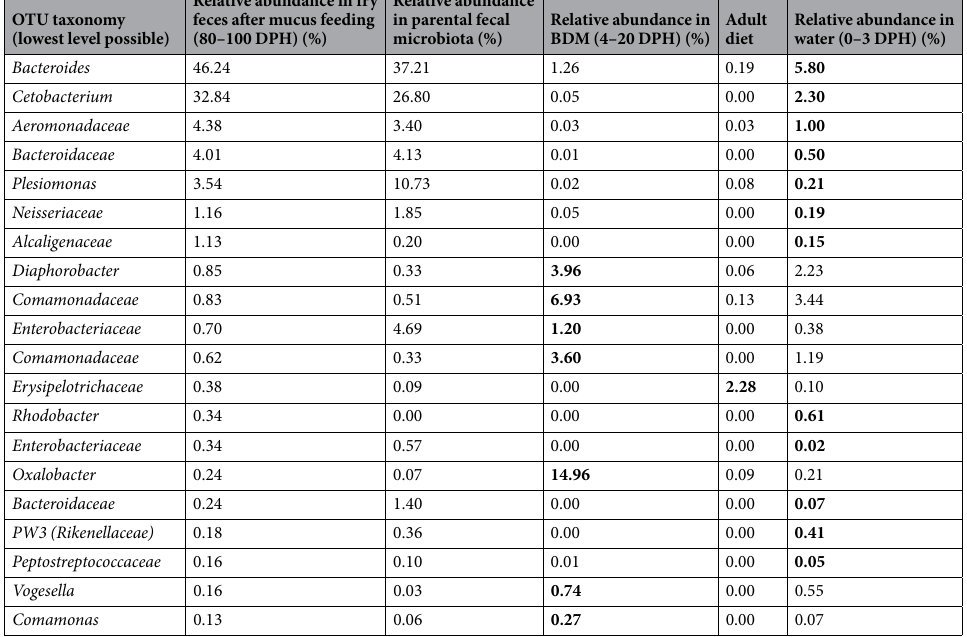
Table 4. The most abundant fecal microbial symbionts of the fry after mucus feeding (80–100 DPH) are differentially shared between the fry and three microbial niches which are potential sources of symbionts for inoculation of the fry microbiota during development: breeding discus mucus, adult diet, and environmental water. In this table, the fry development stage at 80–100 DPH was used instead of fry at 50–80 DPH, because its taxonomic structure is non-significantly different from the adult fecal microbiota. The relative abundance of each taxa was printed in bold in the potential microbial source (breeding discus mucus, adult diet, and environmental water) where they were the most abundant. The parental feces were included in this table as a comparison to fry feces at 80–100 DPH. Parental feces were not considered as a potential microbial source, as the recruitment index from this niche was not significant at any of the developmental stages (0–3, 4–20, 50–80, 80–100 DPH), see Fig. 3. Non-breeding discus mucus is intentionally not included in this table as it is not a potential source of microbial symbionts for the fry. In this table, “BDM” stands for “Breeding discus